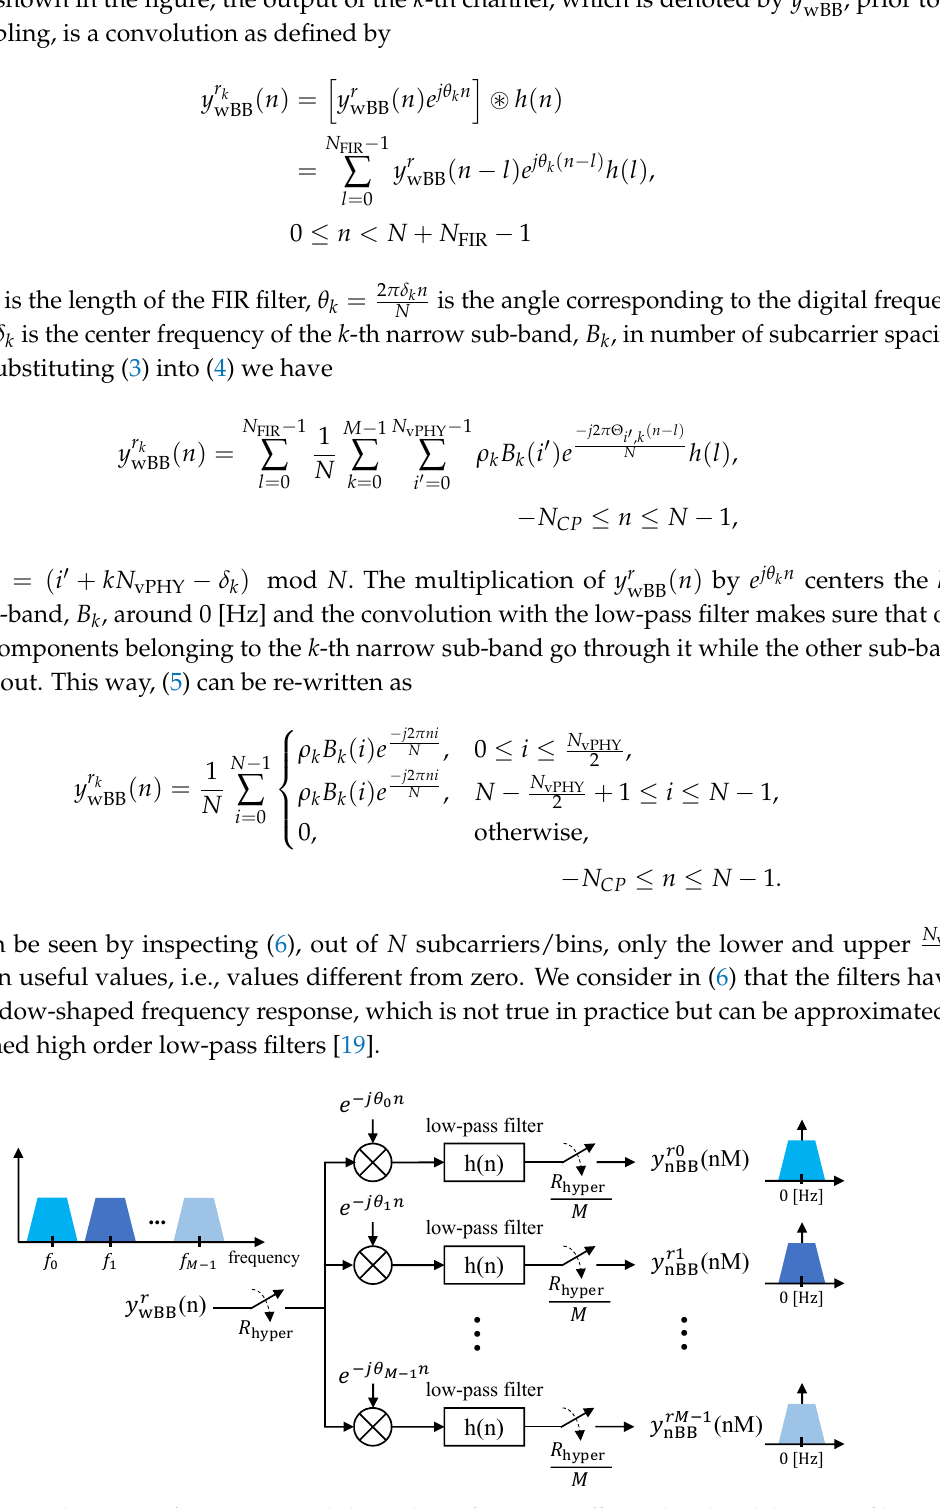
Figure 5. Architecture of a conventional channelizer: frequency offset to baseband, low-pass filters, and